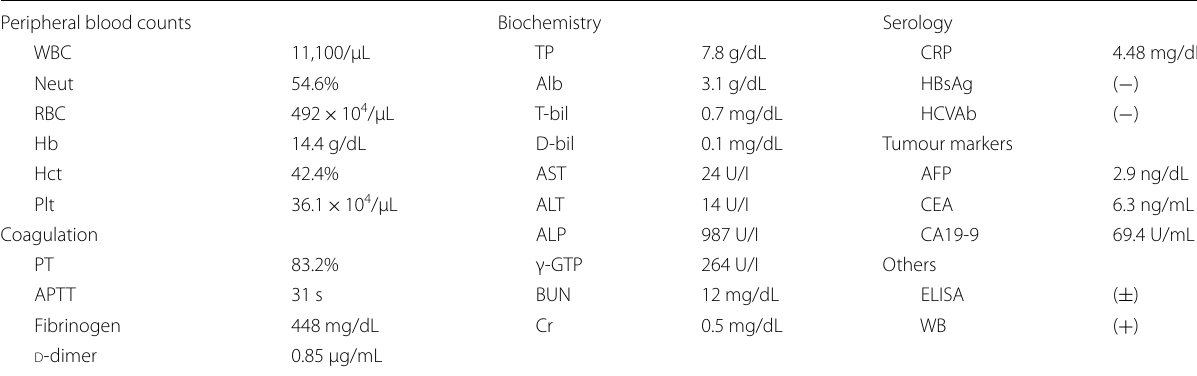
Table 1 Laboratory data of the patient